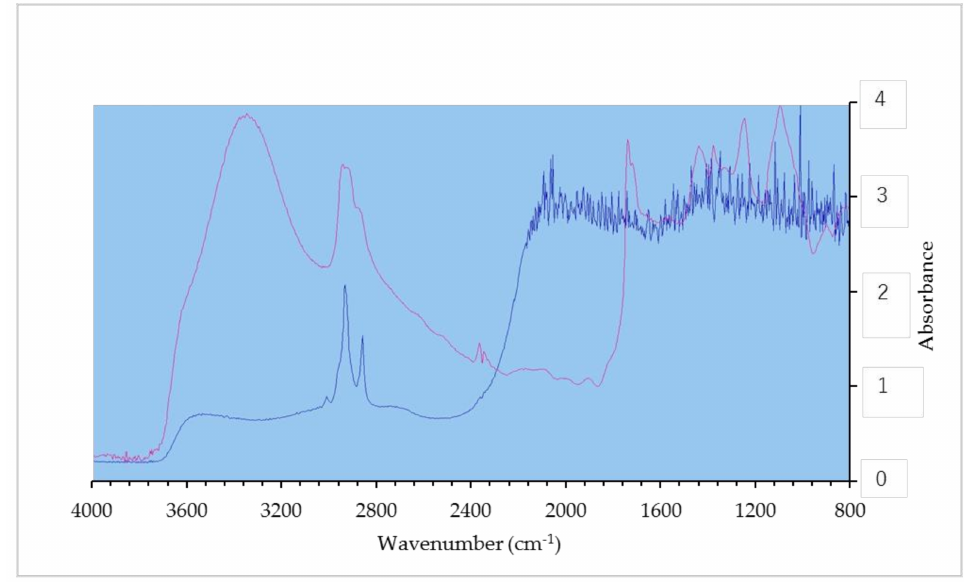
Figure 8. Micro-ATR FTIR spectra of the medulla and oleic acid. Red line—medulla and blue line— oleic